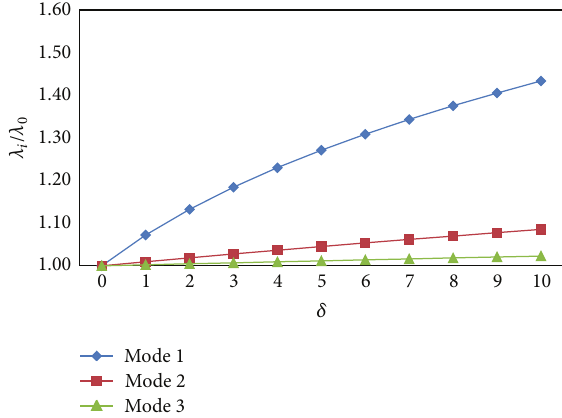
Figure 4: Effect of elastic foundation parameter on the vibration frequencies for 𝑆 0 = 10 5 , 𝑆 𝐿 = 10 5 , Ω 0 = 10 , and Ω 𝐿 = 10 .